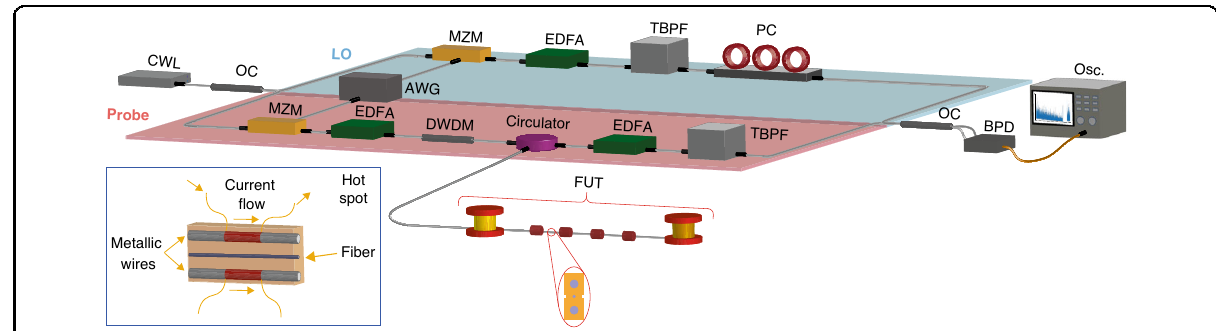
Fig. 6 Experimental setup for time-expanded Φ OTDR. OC: optical coupler. Osc.: oscilloscope. The remaining acronyms are explained in the text. The inset in the lower-left corner is a sketch of the employed hotspot for the temperature sensing